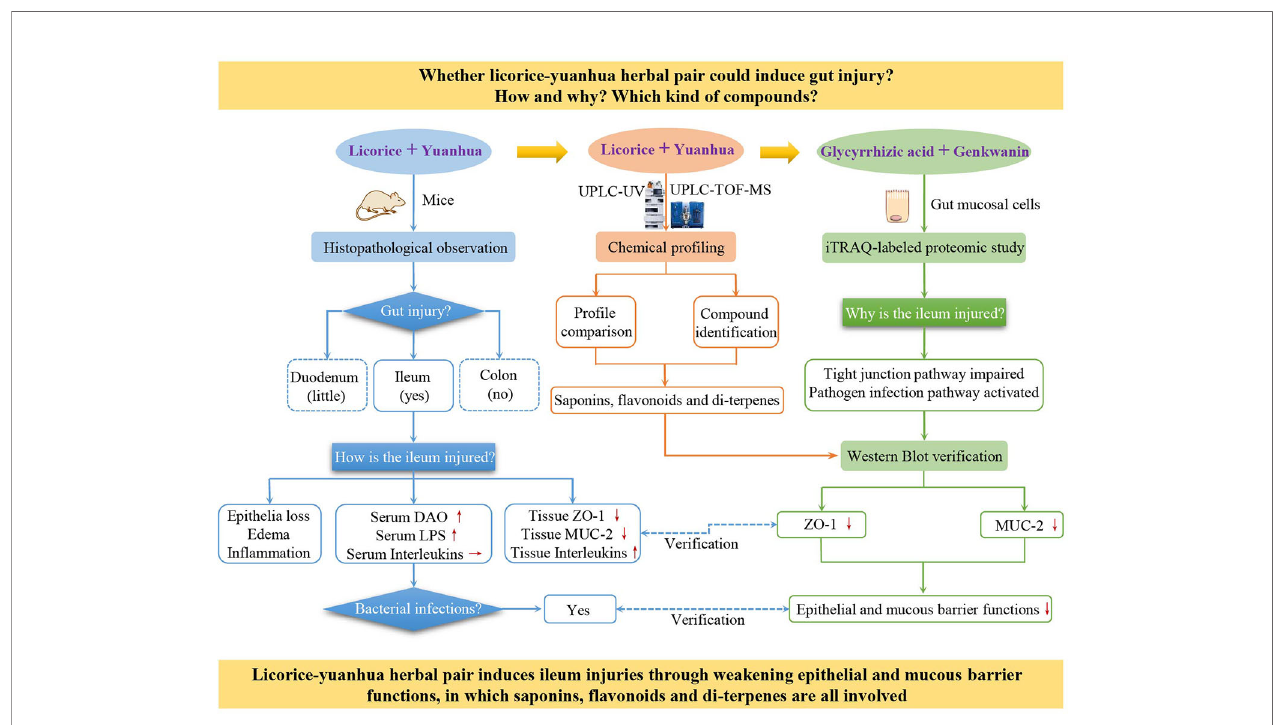
FIGURE 1 | Research frame of this study. The “ + ” symbol means combination, red up and down-arrows mean increased and decreased, respectively, and a horizontal arrow means not